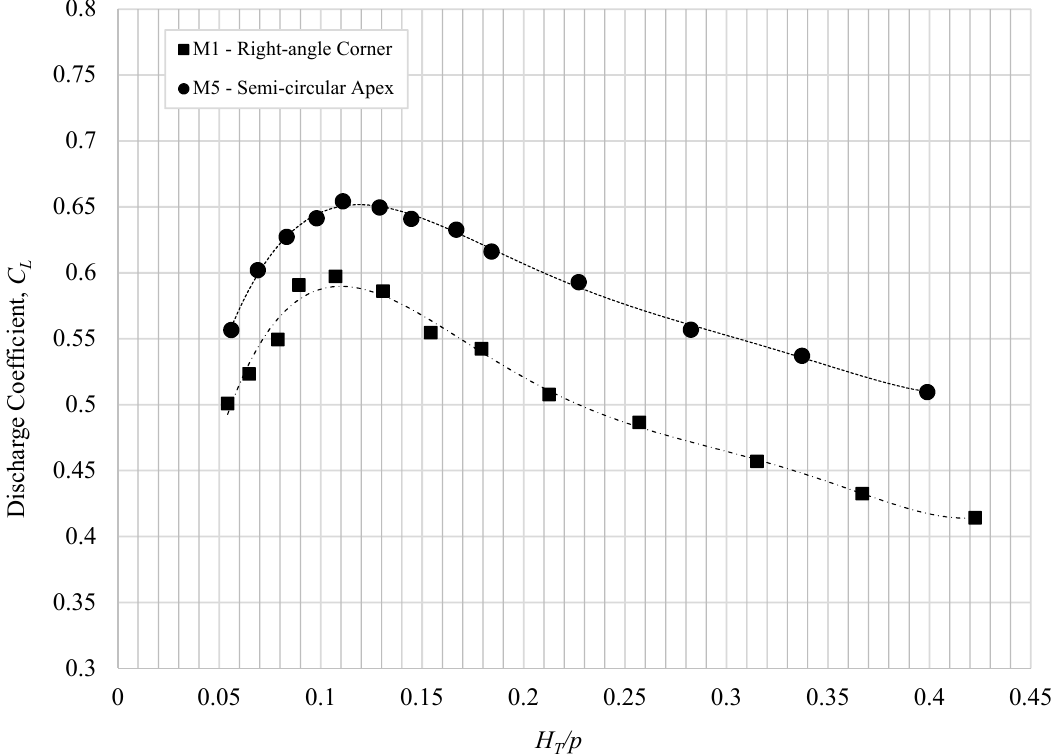
ffi cient ( C / P for M1 and M5 Figure 11. Discharge coefficient ( C L ) versus H T / P for M1 and M5 models. Figure 11. Discharge coe L ) versus H T Figure 11. Discharge coefficient ( C L ) versus H T / P for M1 and M5 models.